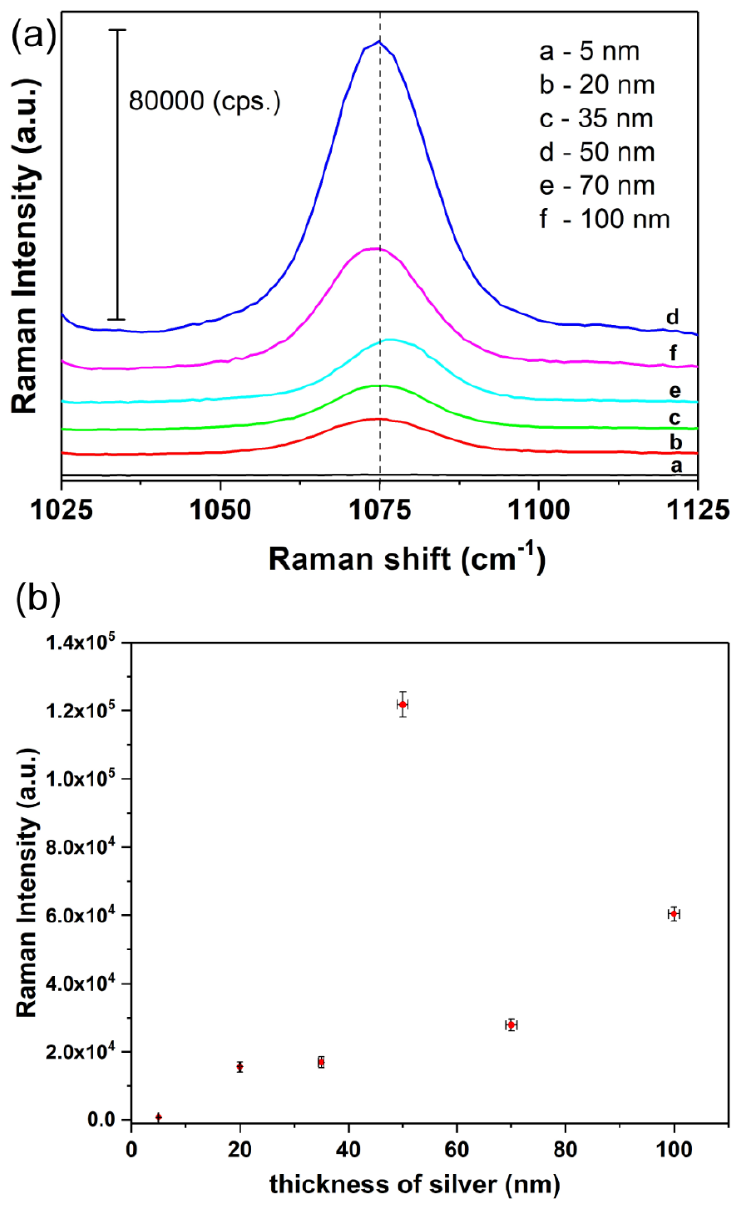
Figure 6. The intensity of SERS band at 1075 cm − 1 with varying Ag metal thickness (5 nm, 20 nm, 35 nm, 50 nm, 70 nm and 100 nm) for Type I surface: mesh 80 × 800: ( a ) Raman spectra, ( b ) numerical values of Raman intensity. The error bars in the Figure 6b shows standard deviation of both thickness of the silver layer and Raman signal intensity.